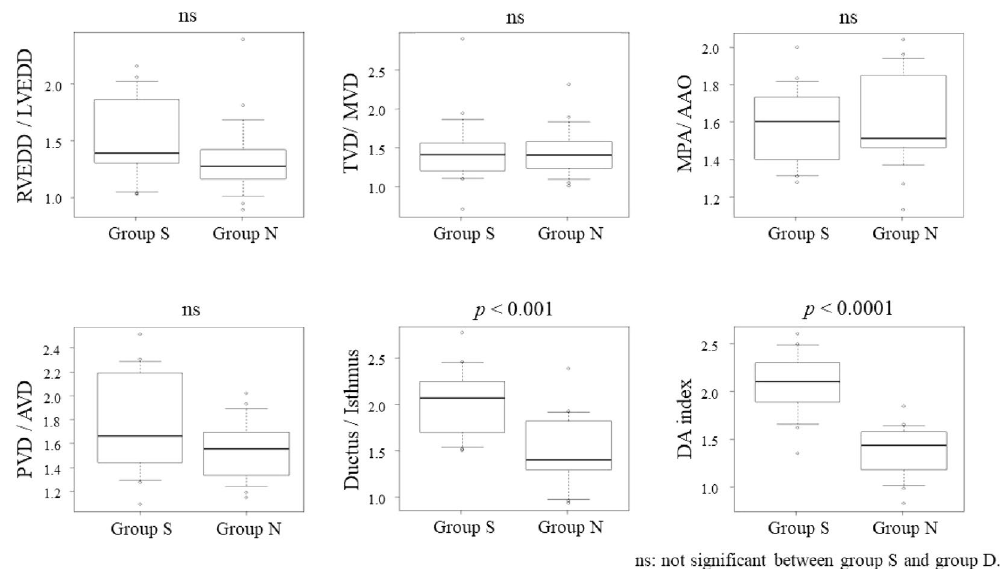
Figure 2. Ratio of cardiac parameter. Box-and-whisker diagram comparing different ratios of cardiac parameters. RVEDD right ventricle end-diastolic diameter, LV left ventricle end-diastolic diameter, TVD